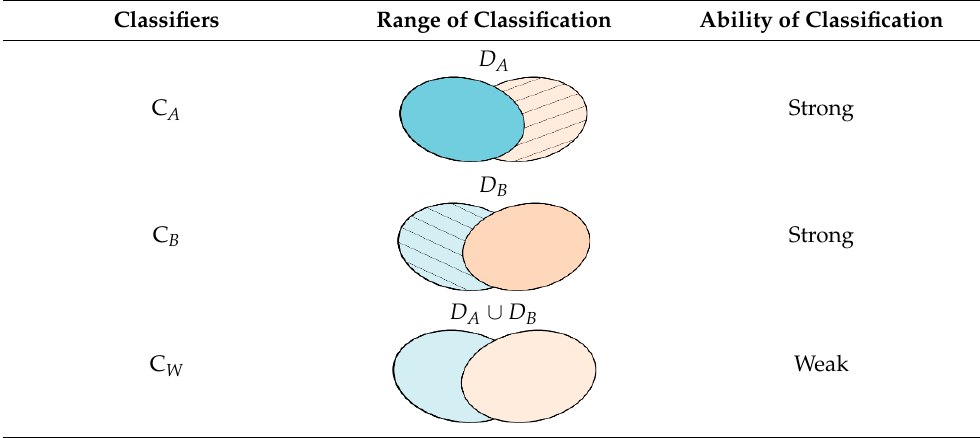
Table 1. Classification range and ability of the three classifiers.